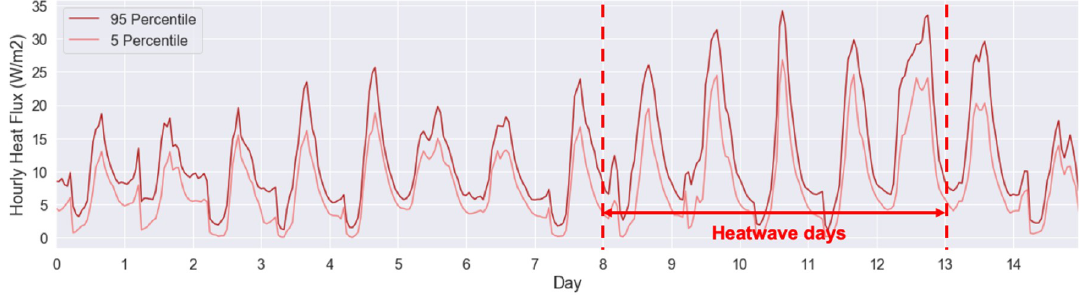
Figure 17. Percentiles of the heat emission intensities: large single‐family houses.